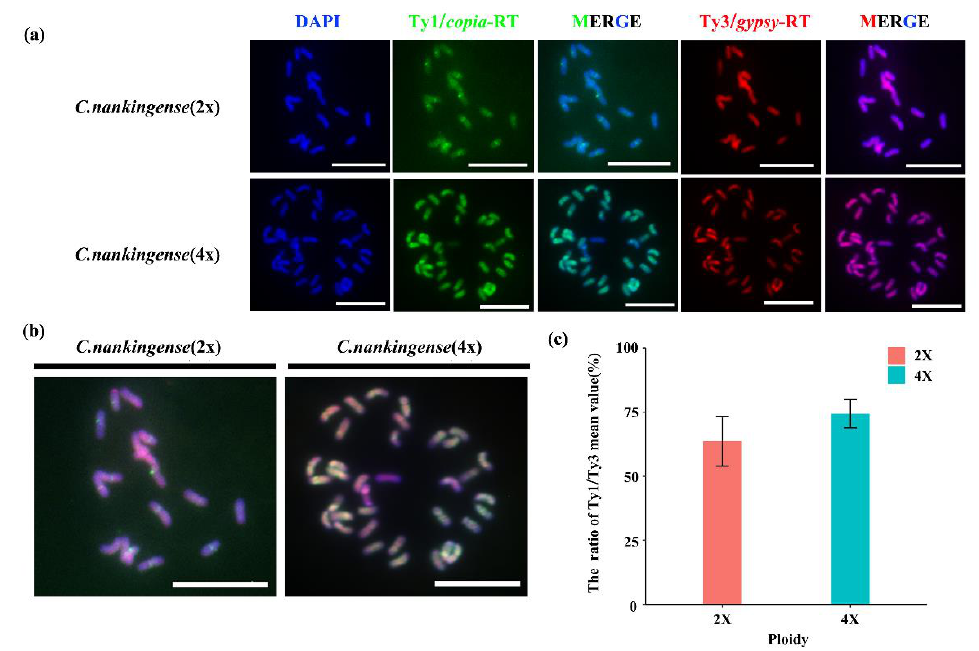
Figure 5. Fluorescence in situ hybridization (FISH) analysis of diploid and tetraploid species of C. nankingense (bar = 10 μm). ( a ) FISH result of Ty1/ copia -RT (green) and Ty3/ gypsy -RT (red) in diploid and tetraploid species of C. nankingense . ( b ) All channels merged images of diploid and tetraploid species of C. nankingense. ( c ) The statistical results of fluorescence intensity between diploid and tetraploid species of C. nankingense .